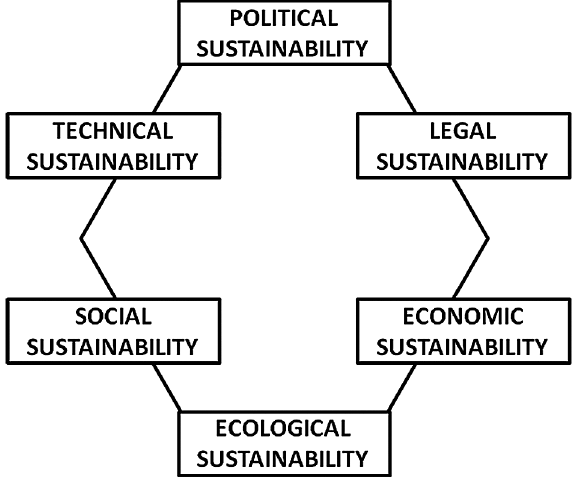
Fig. 1. Hexagonal diagram of conditions for landscape